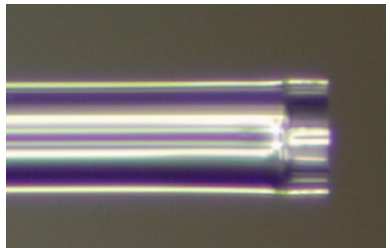
Figure 4. Welding and cutting of fiber glass tubes.